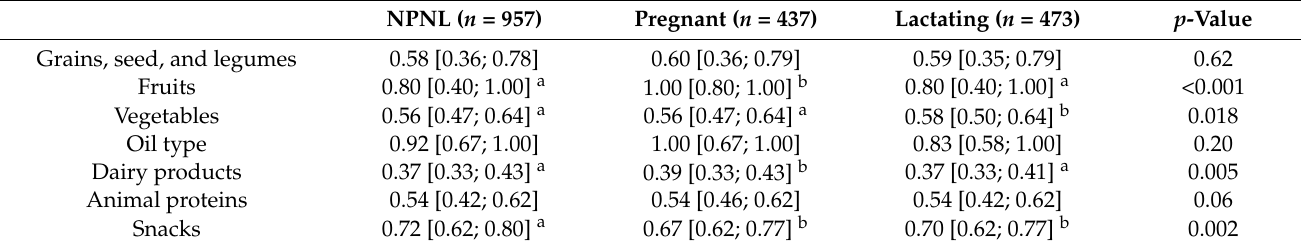
Data show median and interquartile range [Q1; Q3]; p -value was reported by Kruskal-Wallis test. Data labeled with a different letter represents statistically significant differences with a p -value < 0.05 by Dunn’s pairwise comparison to adjust for multiple comparisons. NPNL =